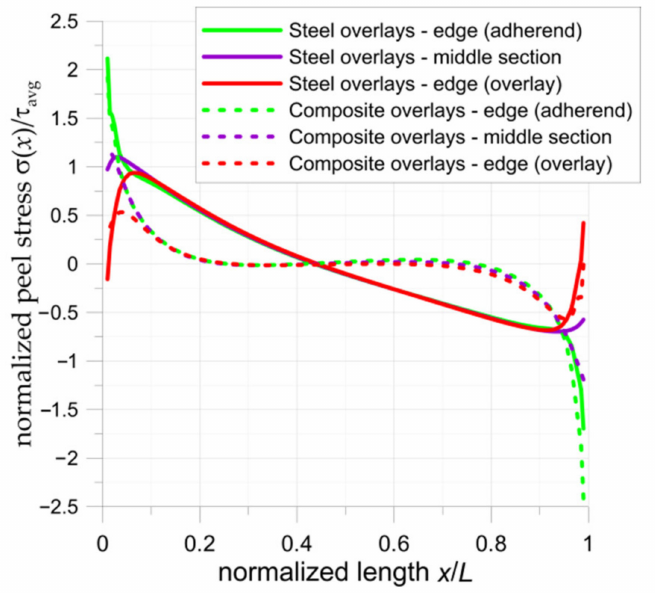
Figure 15. Distribution of normalized peel stresses in samples with double-lap